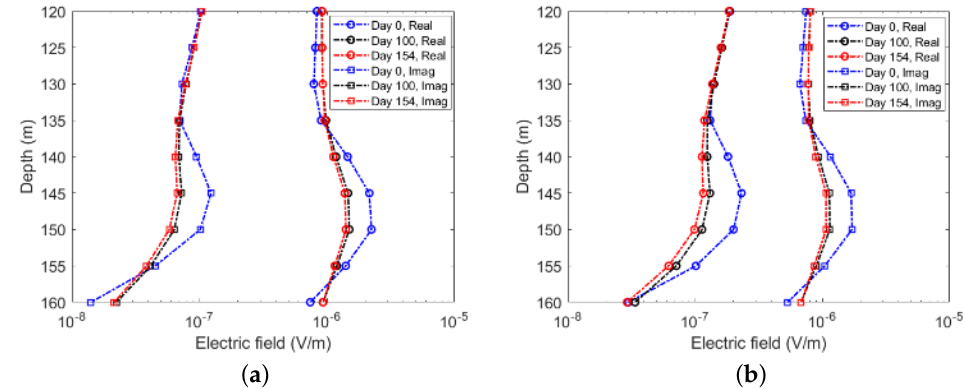
Figure 15. Electric fields from the HED source using the surface-to-borehole method at ( x , z ) = ( − 200 m, − 5 m) with two different Hz. ( a ) 10 Hz. ( b ) 100